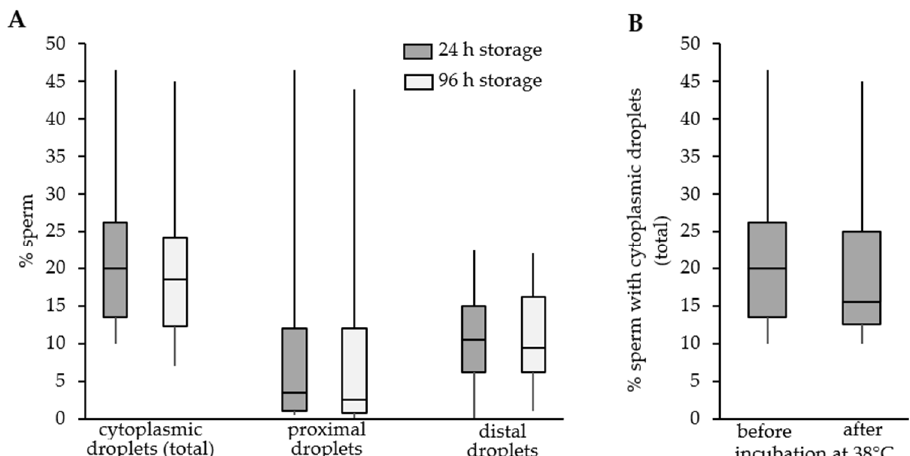
Figure 5. Change in the percentage of sperm with cytoplasmic droplets during storage at 17 ◦ C and subsequent incubation at 38 ◦ C. Semen samples from individual boars (n = 11) were scored for the presence of spermatozoa with proximal or distal cytoplasmic droplets. ( A ) Two hundred cells were evaluated after 24 h and 96 h storage at 17 ◦ C in the BTS extender. Cells were fixated in fixating buffer prior to evaluation. ( B ) Similarly, cells were evaluated after 24 h storage prior to or after 120 min incubation at 38 ◦ C. No significant difference was observed due to storage or incubation time ( p > 0.05). Incubation at 38 ◦ C after 96 h storage had also no effect (data not shown).